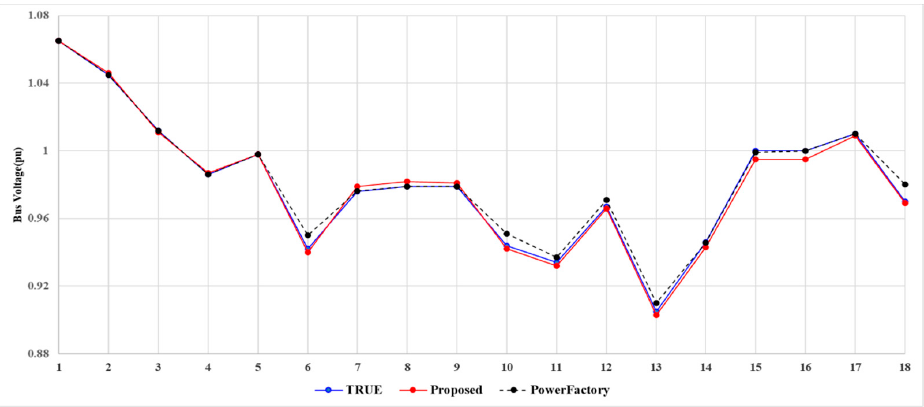
Figure 10. Voltage magnitude among the true value, the proposed algorithm and PowerFactory.